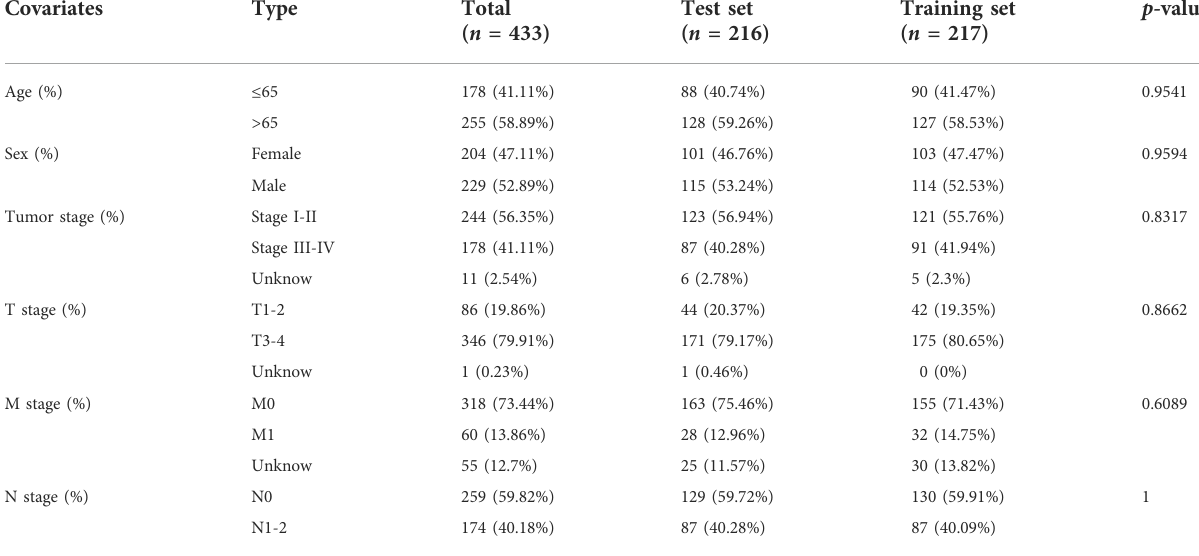
TABLE 1 Clinicopathological information of the patients with CRC in TCGA.